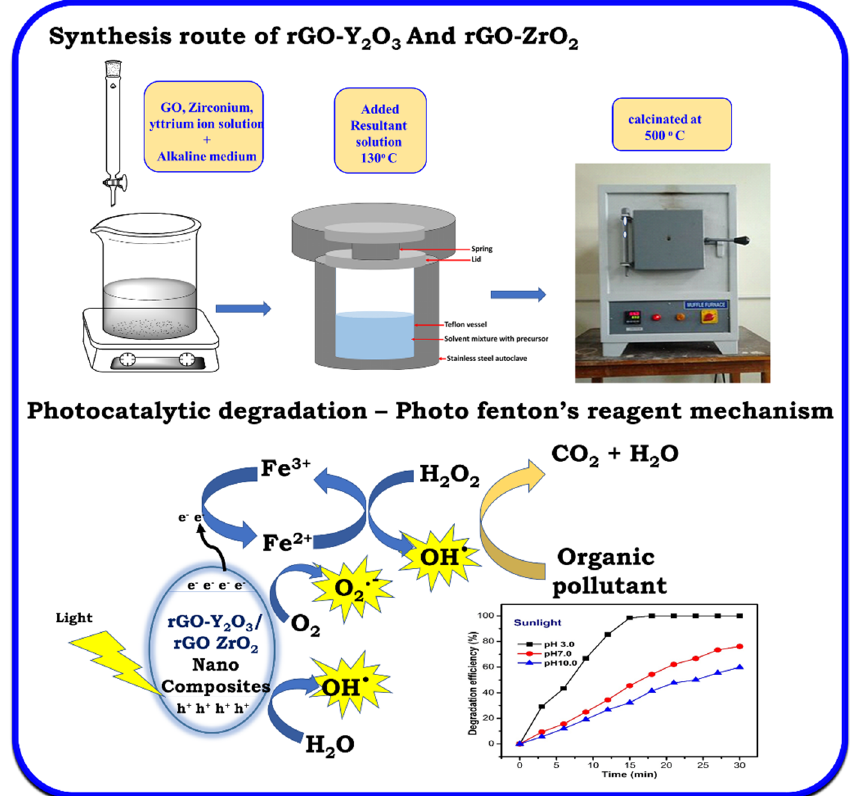
Figure 8. Schematic diagram of catalyst preparation and photocatalytic picric acid